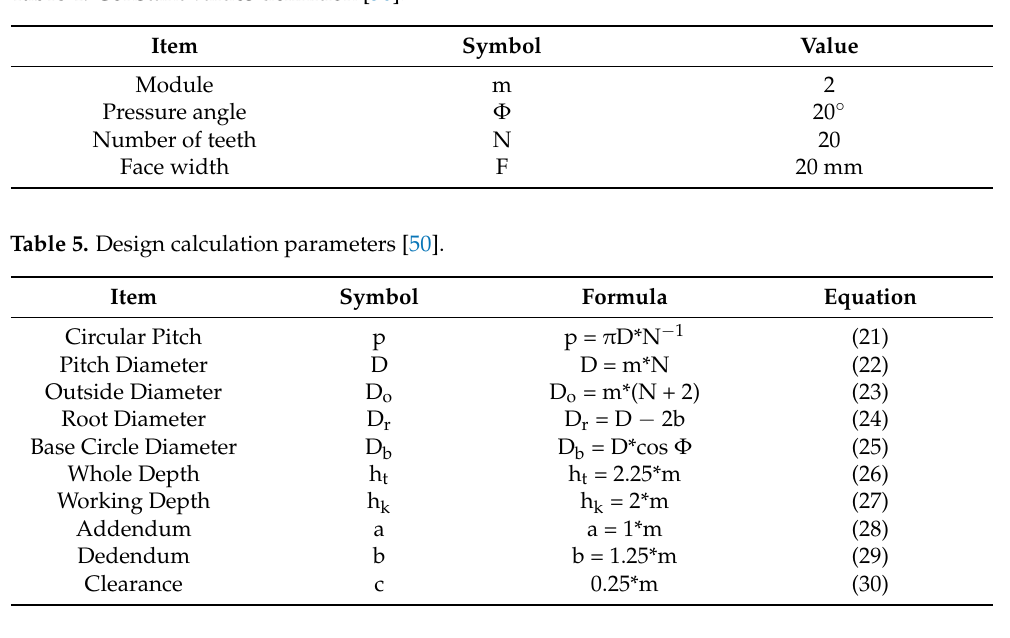
Table 4. Constant values definition [50].